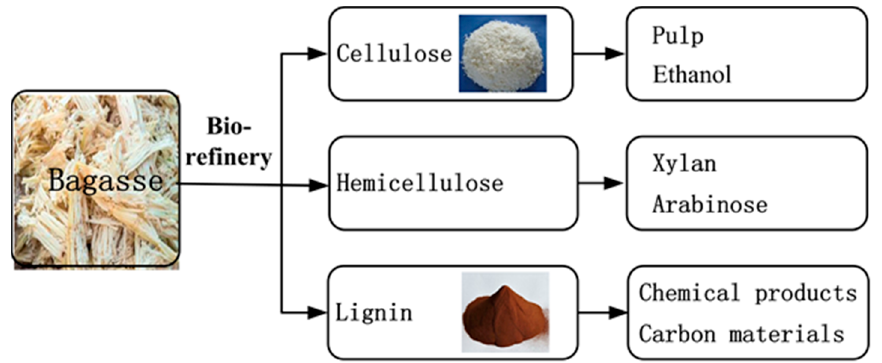
Figure 1. The sugarcane bagasse is refined into cellulose, hemicellulose, and lignin using an ethanol-based organosolv technique. The cellulose is used for the production of pulp and ethanol fuel, the hemicellulose is used for the medicinal and nutritional product xylan, and the lignin is used for the fabrication of graphene microcrystals (GMC) described in this study.